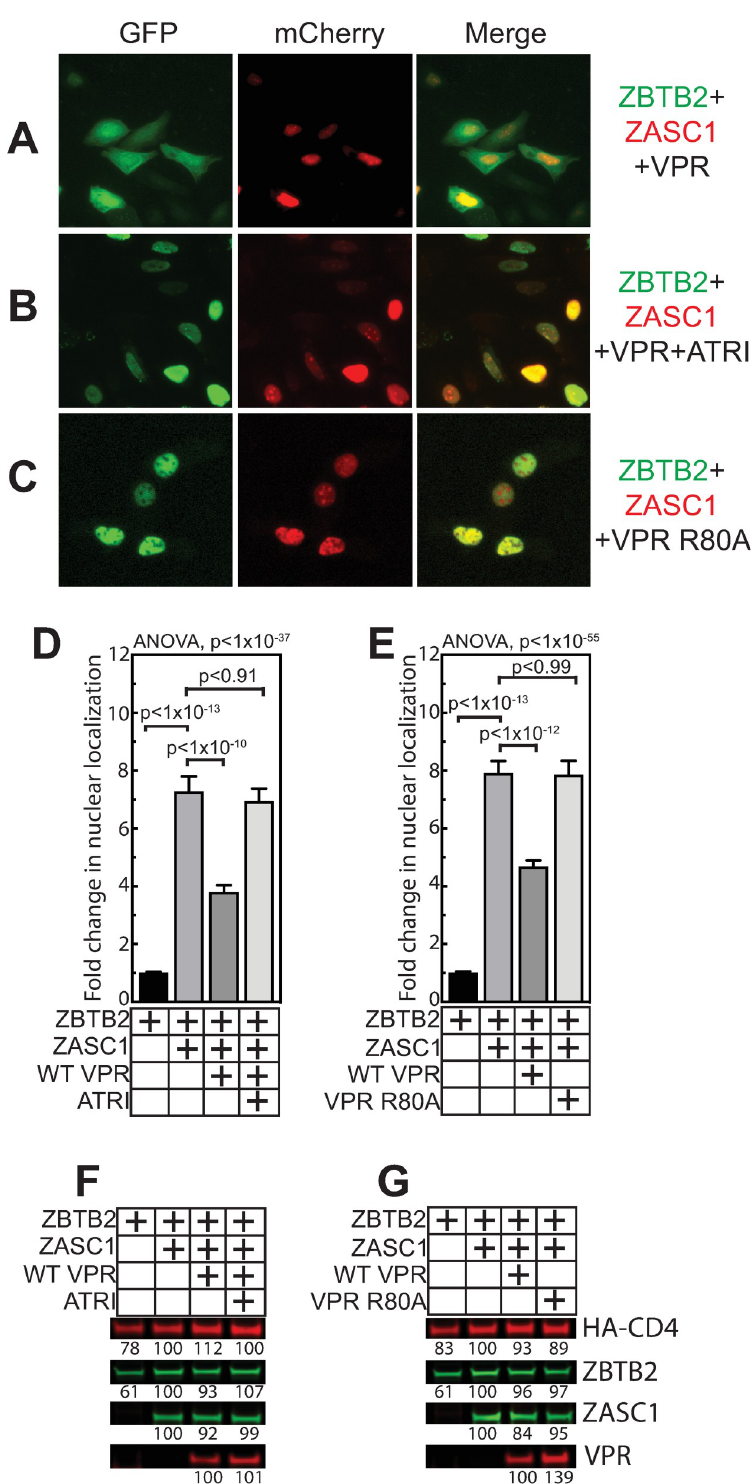
Fig 11. Vpr activation of the ATR kinase pathway regulates ZBTB2 localization. U2OS cells were transfected with GFP-ZBTB2 and mCherry-ZASC1 and imaged 24 hours post transfection. Co-expression of WT Vpr (A) resulted in a primarily cytoplasmic ZBTB2 localization which was reversed (B) by treating with 10 μ M of ATR inhibitor (CAS 905973-89-9). (C) Co-expression of the cell-cycle arrest-deficient Vpr R80A mutant failed to relocalize ZBTB2 to the